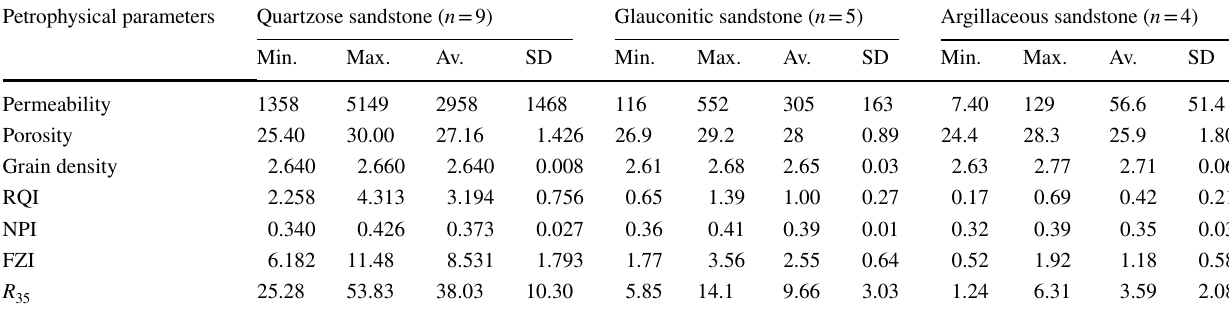
Table 1 Values of the petrophysical characteristics obtained from the conventional core analysis (CCA) for the studied Abu Madi sandstones